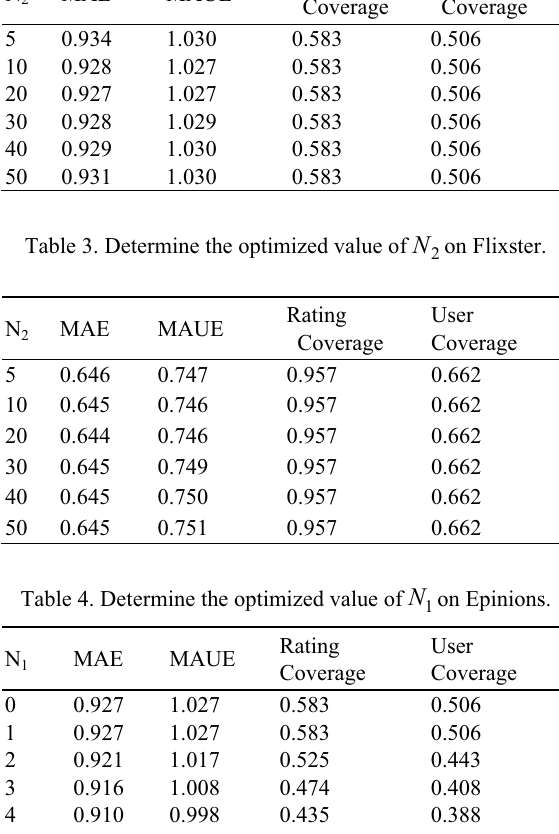
Table 2. Determine the optimized value of 2 N on Epinions.